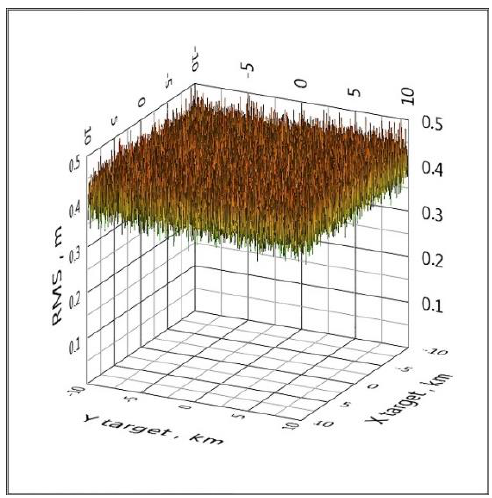
when Gaussian noise is added to the TDoA values with a standard deviation of 0 ps (GPS).